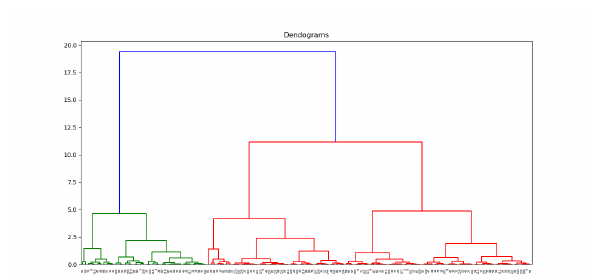
Figure 3: Dendrograms for selecting clusters in the temporal data set (here humidity as a considered parameter).